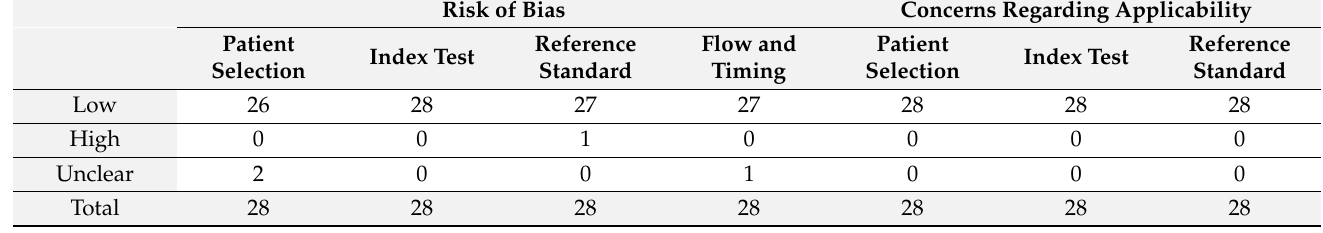
high risk; ? indicates unclear risk. Table 2. QUADAS-2—Number of studies at low, high, or unclear risk of bias and concerns regarding applicability.